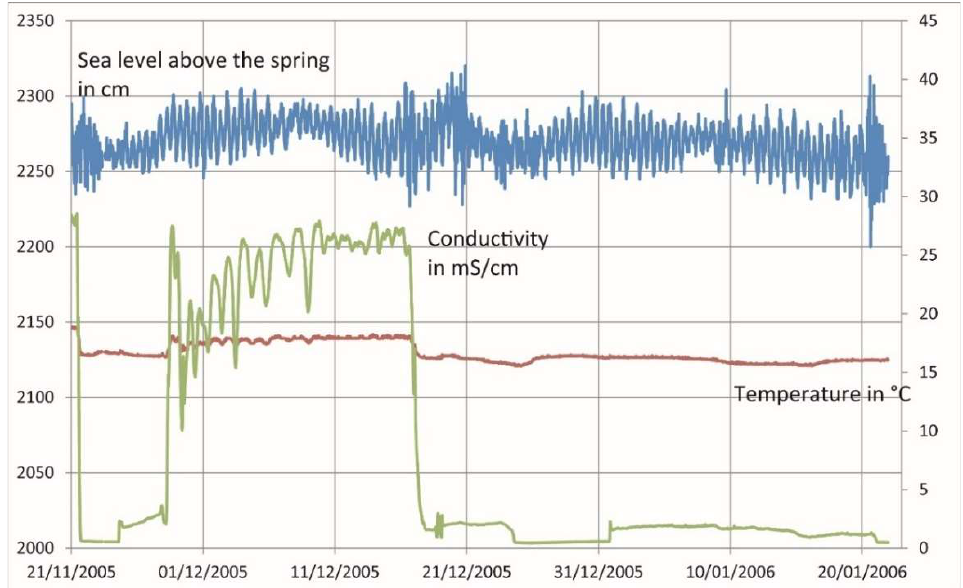
Figure 4. Seasonal variation of conductivity and temperature at S2, compared to sea level. During floods at the end of November and after December 21, the conductivity is low, indicating no sea water intrusion. At the beginning of December, the flow regime not modified by floods is obviously influenced by sea water intrusion occurring in S12 and S13. Therefore, the effect of tide controls the conductivity.